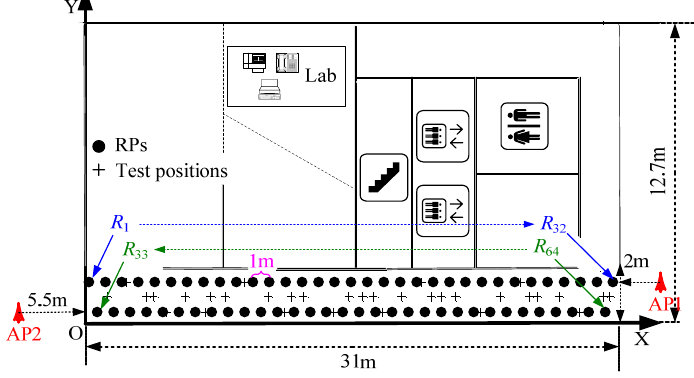
Figure 11. Experimental setup with two APs, 64 RPs and 33 test